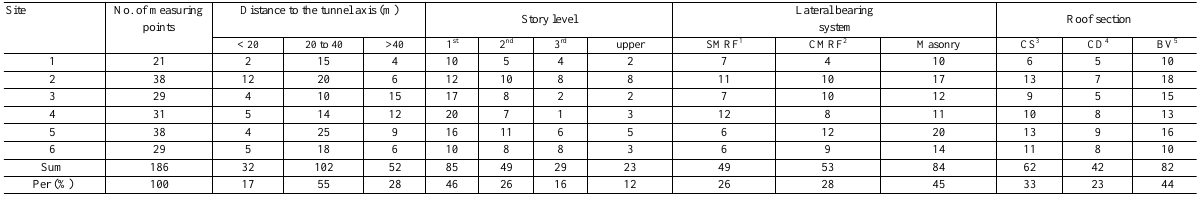
1. SMRF: Steel Moment Resistant Frame, 2. CMRF: Concrete Moment Resistant Frame, 3. CS: Concrete Slab, 4. CD: Com- posite Deck, 5. BV: Barrel Vault.